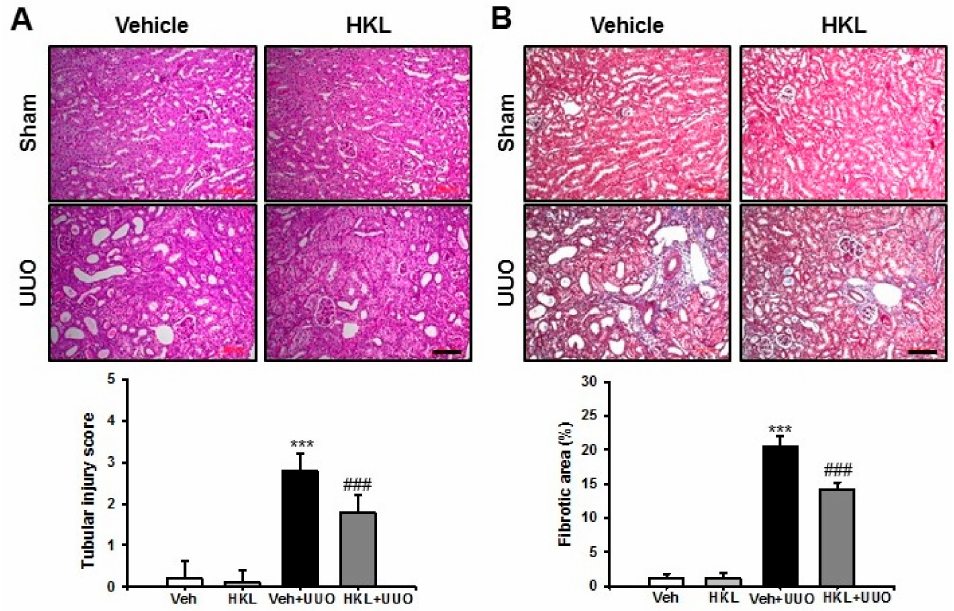
Figure 1. E ff ect of honokiol on unilateral ureteral obstruction (UUO)-induced renal tubular injury and fibrosis. Representative sections of kidneys from sham- and UUO-operated mice treated with vehicle (Veh) or honokiol (HKL) were stained with ( A ) Periodic acid-Schi ff stain (PAS) and ( B ) Masson’s trichrome (MTC). Scale bar = 100 µ m. The bar graph shows semi-quantitative scoring of tubular injury by PAS, area fractions (%) of tubulointerstitial fibrosis, and degree of interstitial collagen deposition stained by MTC in the sham and UUO-operated kidneys. Ten randomly chosen, non-overlapping fields were quantified ( n = 10 per group). Data are expressed as mean ± SD. *** p < 0.001 versus Veh or HKL; ### p < 0.001 versus UUO treatment with Veh; Sham, sham-operated mice; UUO, unilateral ureteral obstruction; Veh, vehicle; HKL,